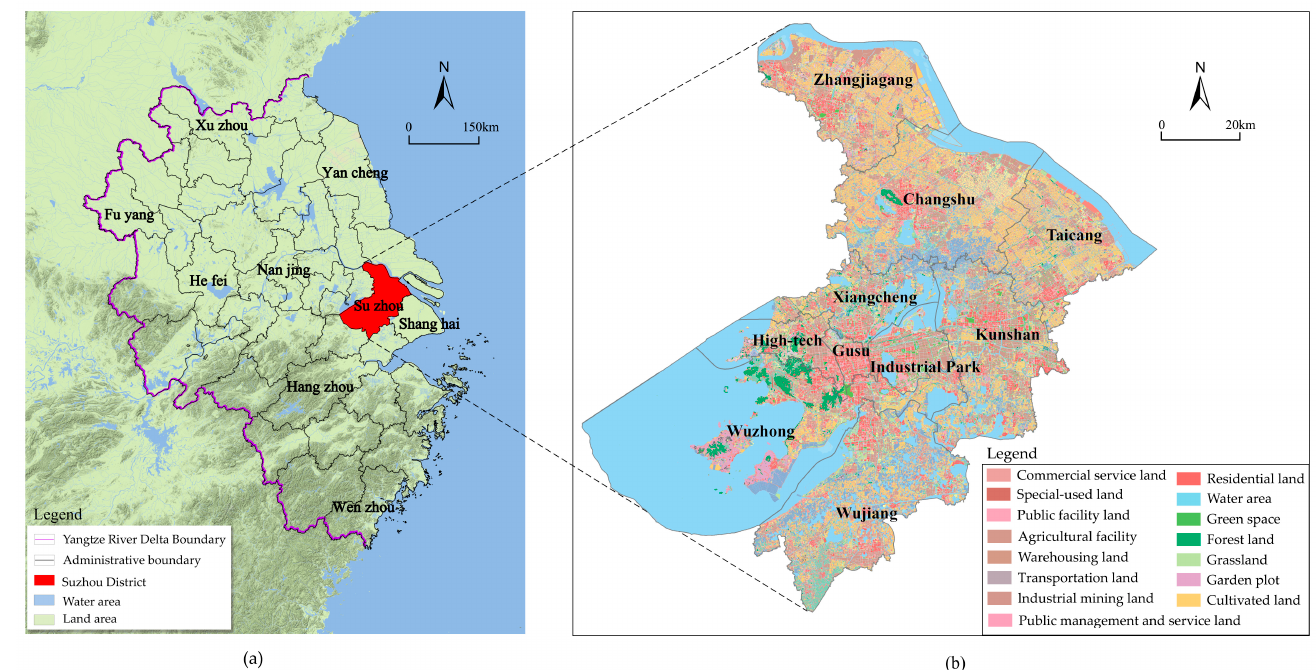
Figure 1. ( a ) Location of Suzhou in the Yangtze River Delta; ( b ) Suzhou land use classification.